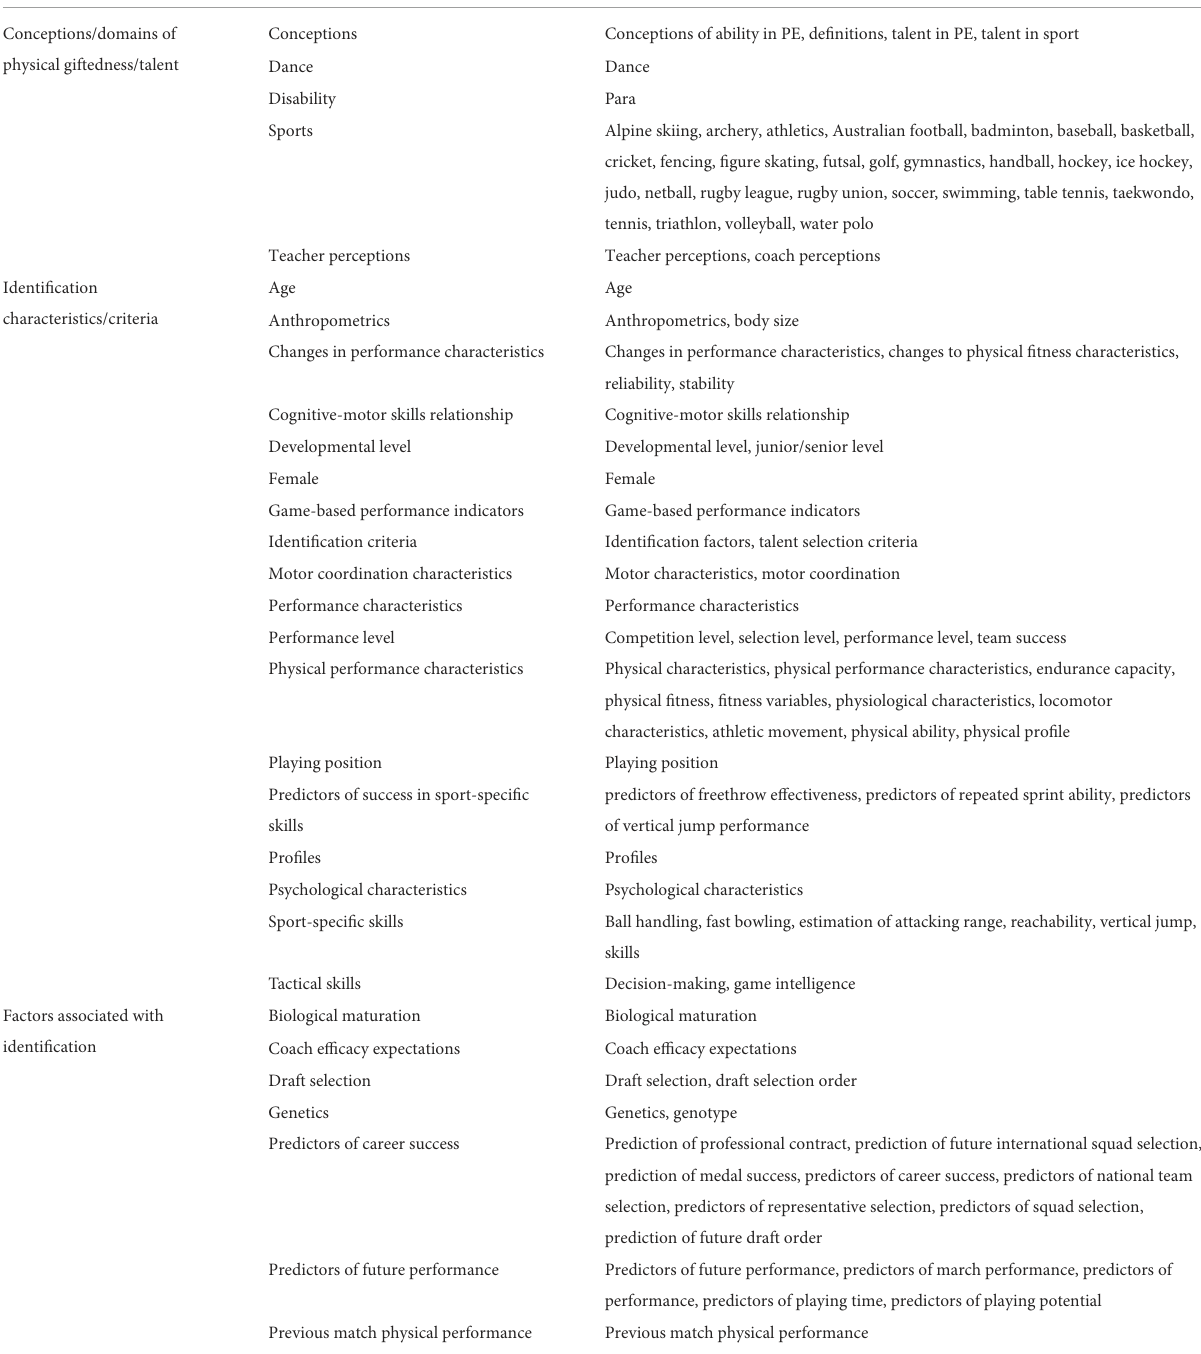
TABLE 1 Major topics of identified